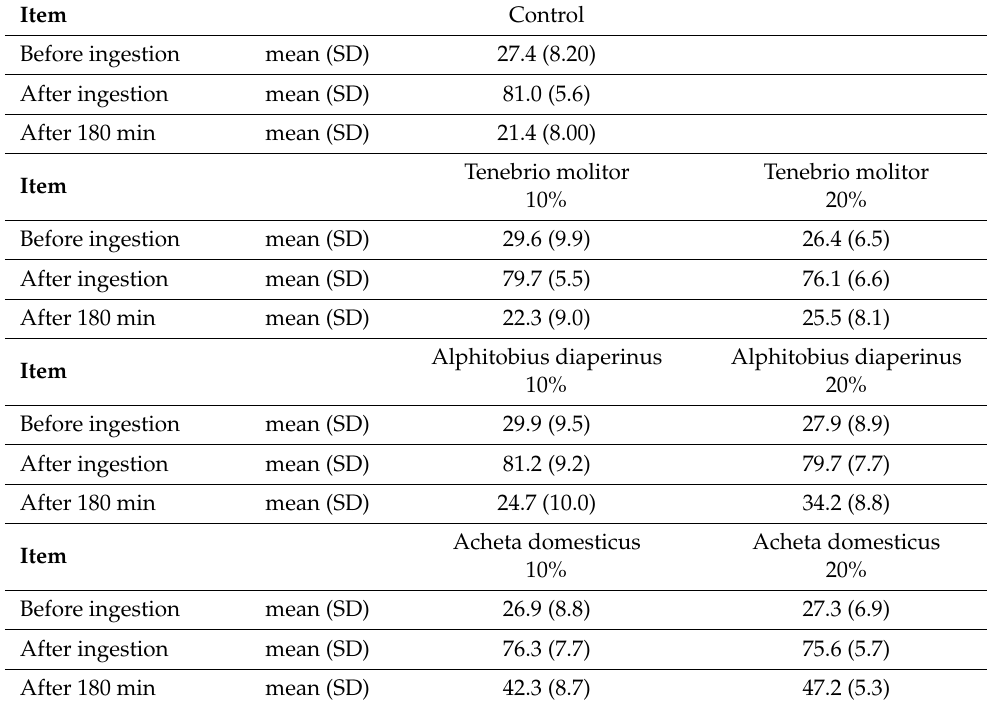
Table 5. The results of the satiety level assessment after the ingestion of food products with the addition of an insect flour for n = 71